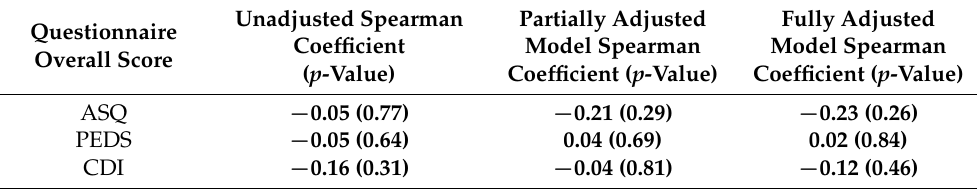
Table A3. Unadjusted correlation between breastfeeding category and questionnaire score.